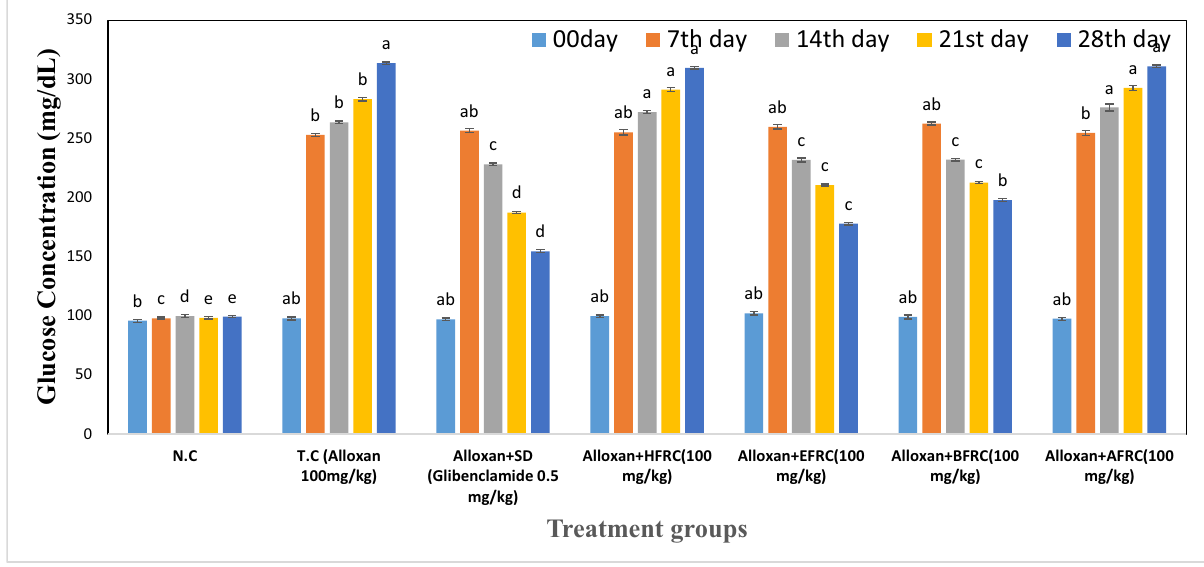
Figure 1: E ff ect of di ff erent fractions of R. cordifolia on BGL of alloxan - induced diabetic mice. Values are expressed as mean ± S.E ( n = 5 ) letters a, b, c … show the signi fi cant ( P < 0.05 ) di ff erence and same letters show nonsigni fi cant ( P > 0.05 ) di ff erences.